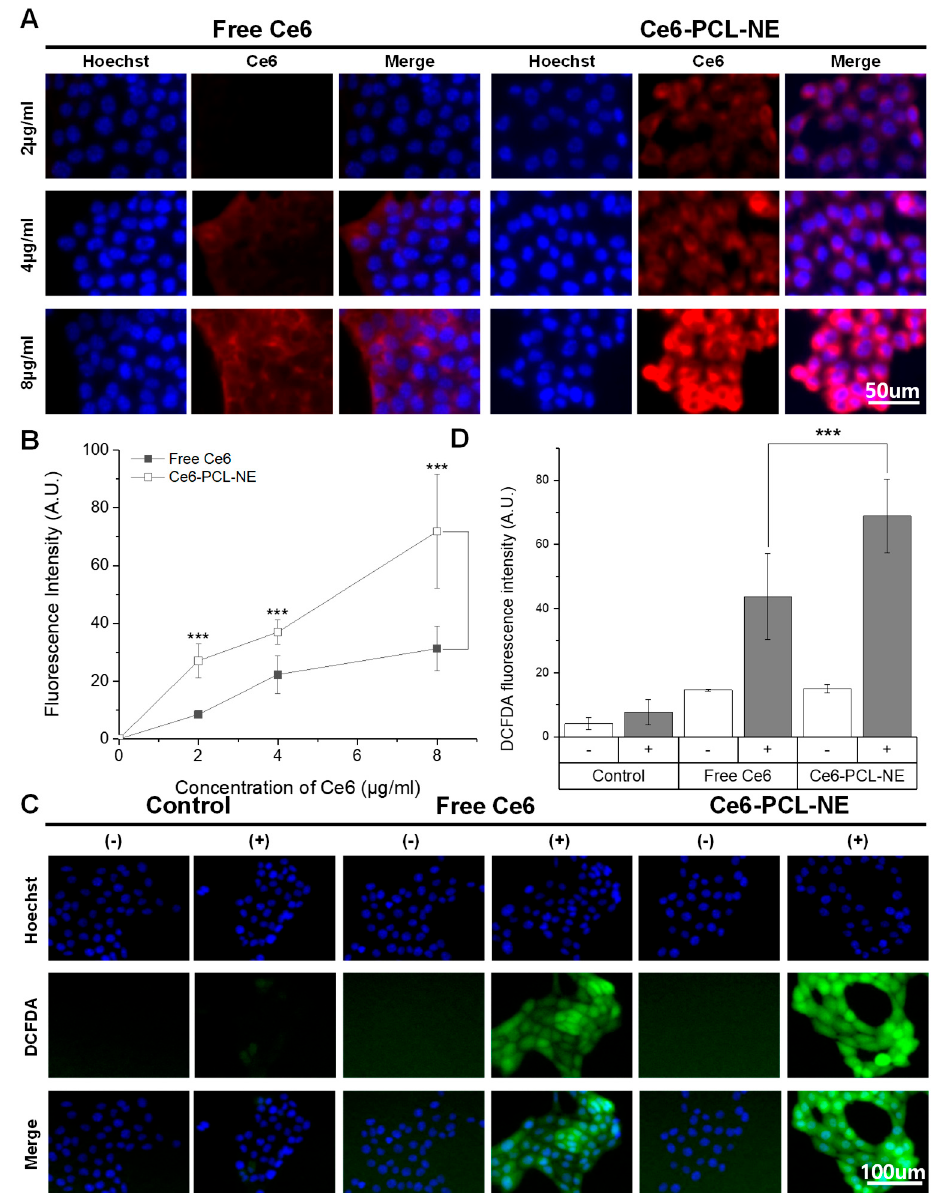
Figure 2. Cellular uptake of Ce6-PCL-NE and ROS generation. ( A ) Fluorescence images of 4T1 tumor cells treated by free Ce6 or Ce6-PCL-NE for 2 h. ( B ) Fluorescence intensity with different concentrations of Ce6. Results represent mean ± s.d. ( n = 10). *** p < 0.001. ( C ) Fluorescence signals of 2’,7’-dichlorofluorescein diacetate (DCFDA) in 4T1 tumor cells treated with free Ce6 or Ce6-PCL-NE for 2 h with or without laser irradiation. ( D ) Fluorescence intensity of DCFDA in ( C ). *** p < 0.001. Results represent mean ± s.d. ( n = 10).